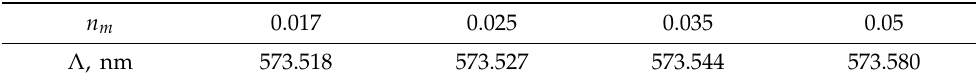
Table 1. Resonant grating periods for 4 values of n m